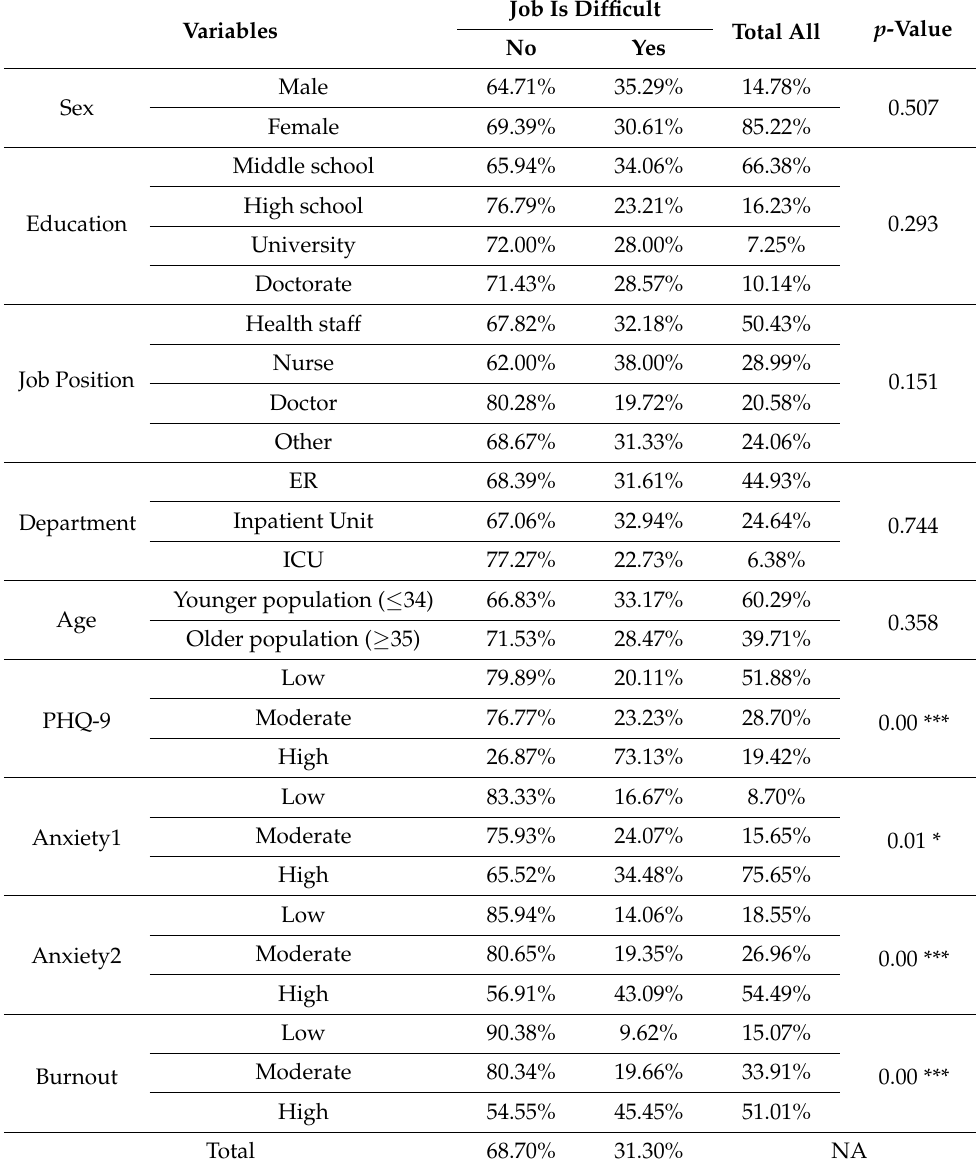
Table 2. Correlation between the demographic and psychological variables and perception of job difficulty. Variables